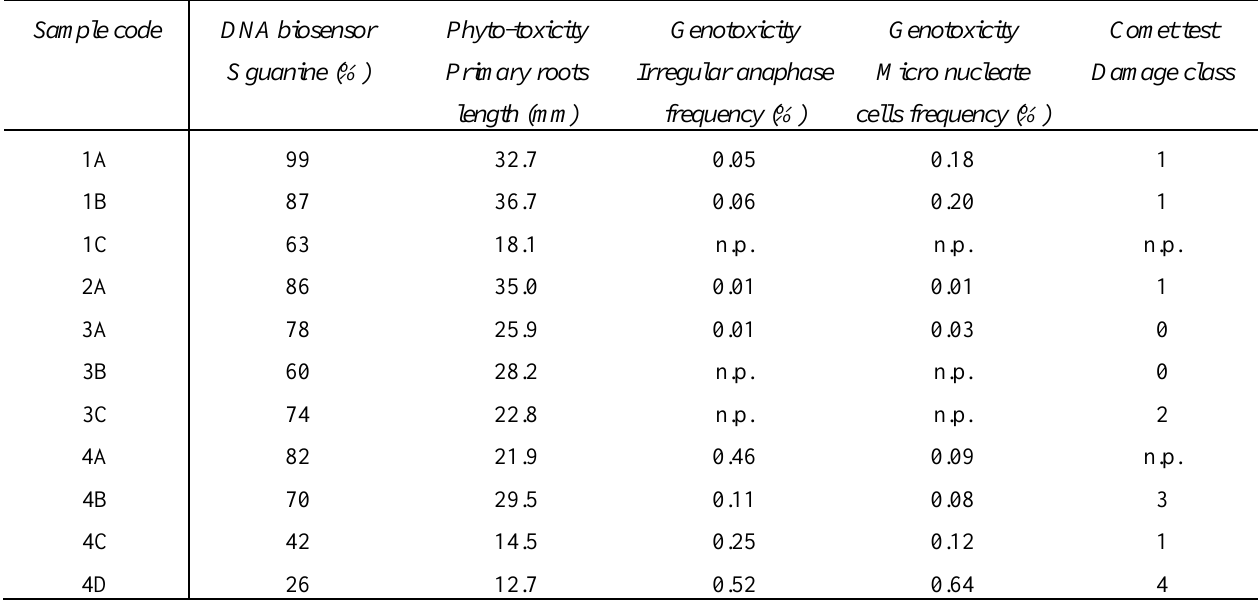
Table 5. Comparison of biosensor results performed on ACNA samples (sampling of 2003) with other bio-assays for toxicity and genotoxicity